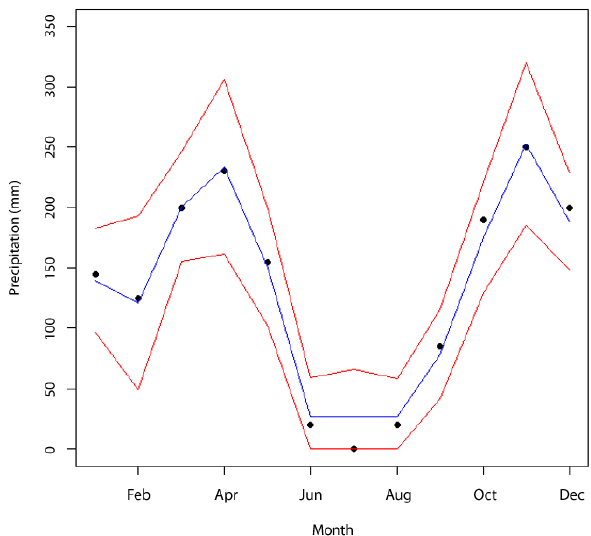
Fig. 3. Simulated distributions of precipitation at Ngamakala. Solid circle, current precipitation distribution according to the climatic database (Leemans and Cramer, 1991); Blue line, mean simulated distribution. Red lines, mean simulated distribution ±